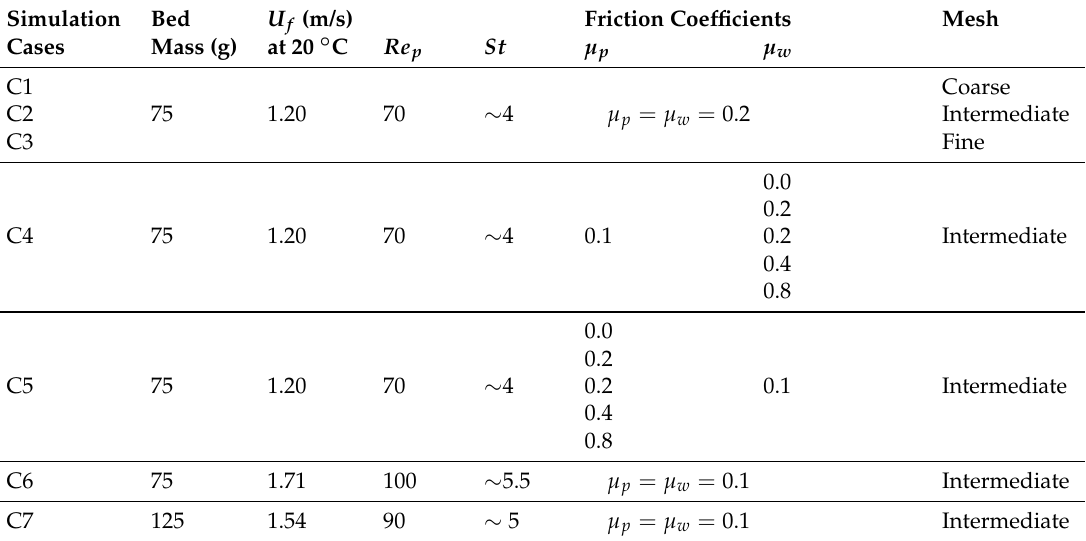
Table 3. Simulation cases with the selected physical and numerical